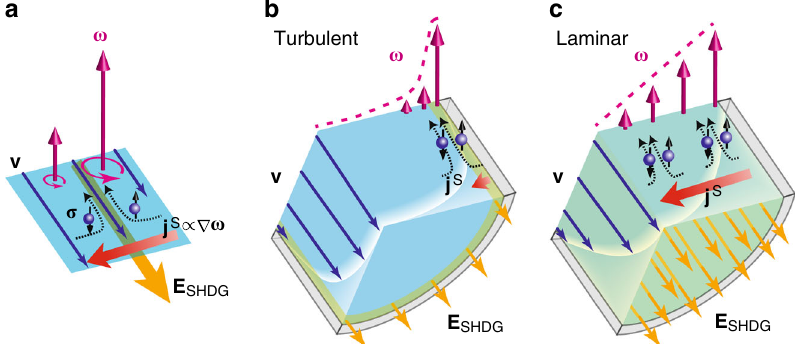
Fig. 1 Spin hydrodynamic generation in a cylindrical channel. a A schematic illustration of SHDG. v , ω , σ , j S , and E SHDG are the fl ow velocity, the vorticity, the spin polarization, the spin current caused by SHDG and the electromotive force caused by the inverse spin Hall effect in a liquid metal fl ow, respectively. b , c Geometries for SHDG in a turbulent fl ow ( b ) and in a laminar fl ow ( c ). Each illustration represents a cut-out part of a fl uid fl ow in a cylindrical channel where SHDG is